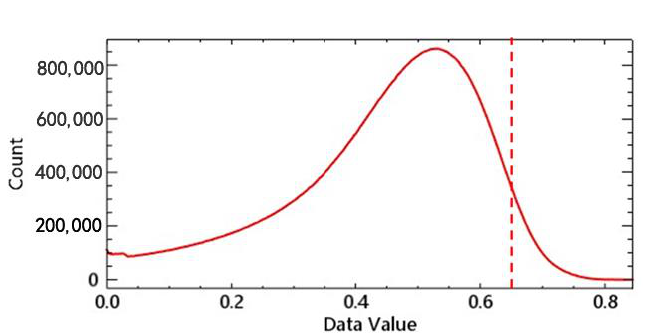
Figure 3. Statistics of normalized difference vegetation index ( NDVI ) values (the dashed line is at 95% of the cumulative frequency of NDVI values). R is the N requirement, N% is the average GNC and NUE is the N fertilizer utilization rate. According to Ling et al. [58], the in-season N fertilizer utilization rate of high-yielding fields ranged from 38% to 45.7%, with an average of 42.45%, where high yields need to be so NUE = 40% in this